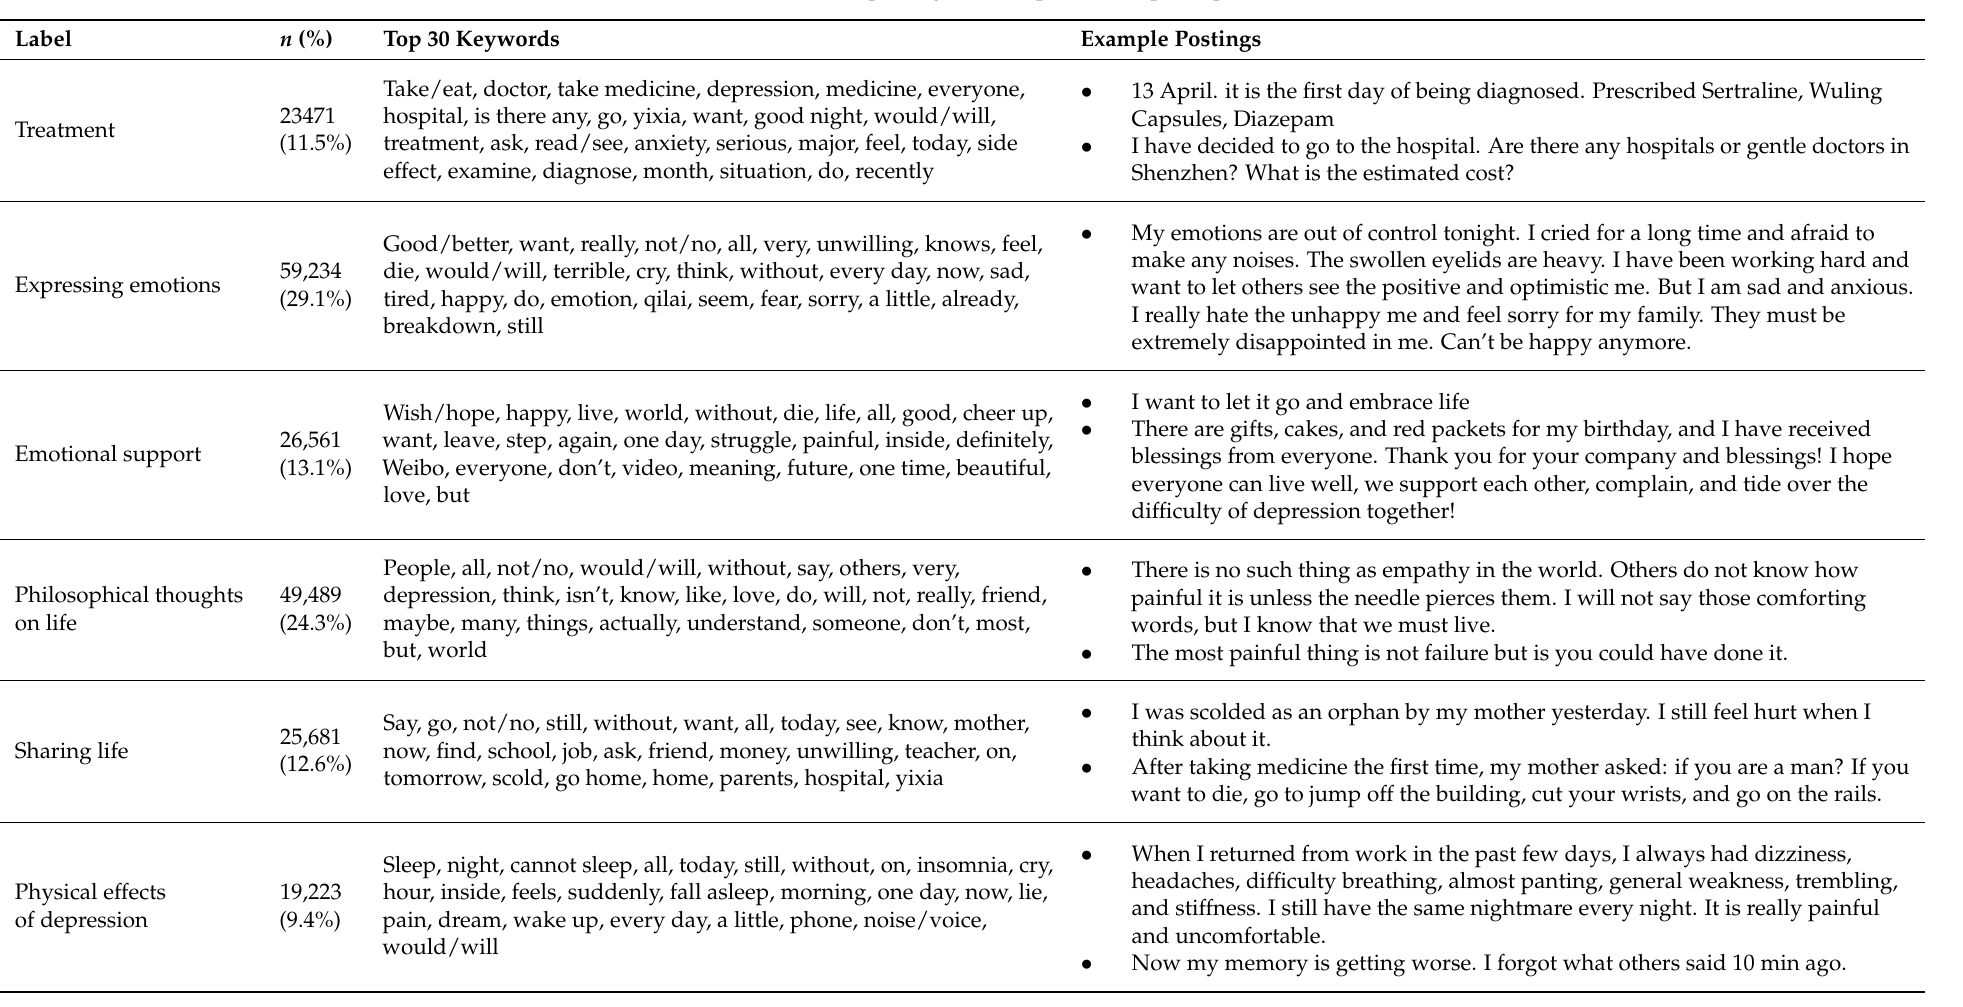
Table 3. Themes of postings from depression Super